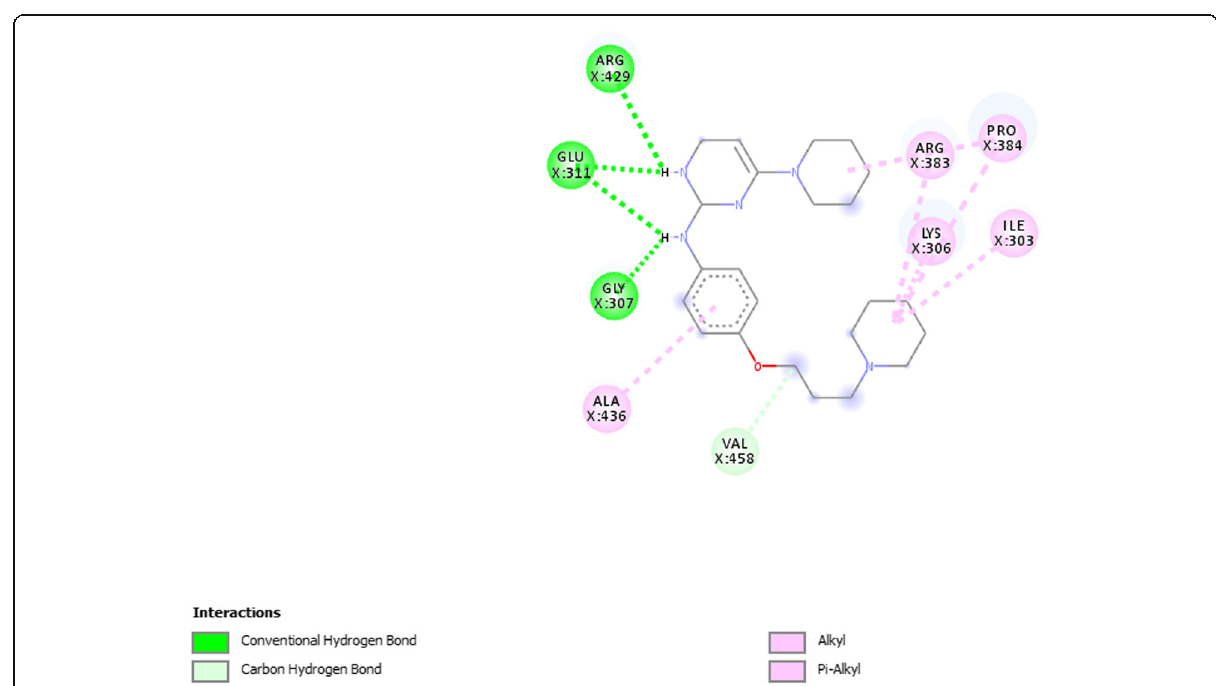
Fig. 7 Receptor – ligand interaction of complex 18 on a 2D diagram